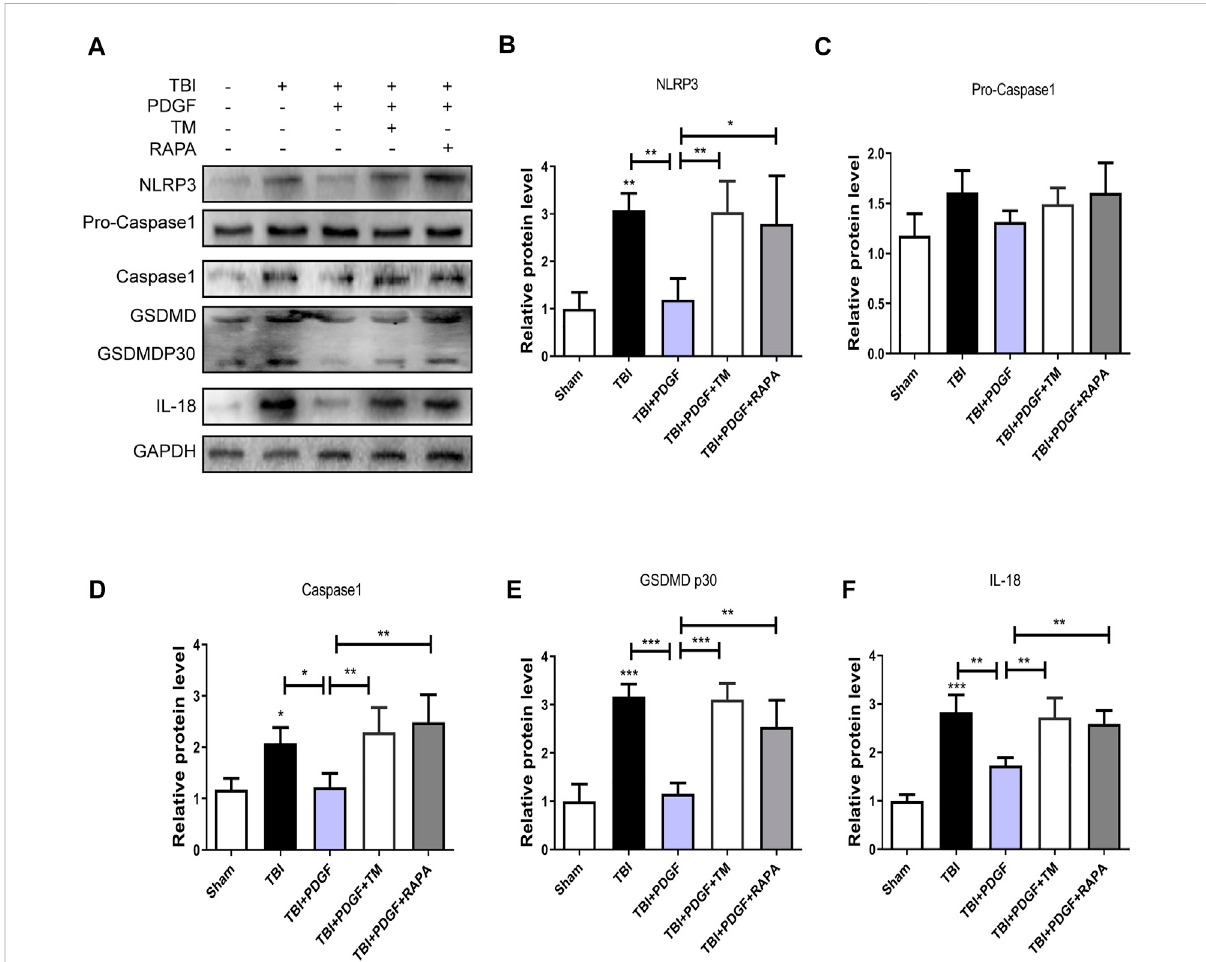
FIGURE 4 PDGF treatment inhibits the pyroptosis by blocking the ER stress and autophagy after TBI. (A) Representative western blot analyses of NLRP3, Pro-caspase1, Caspase1, GSDMD, GSDMDP30 and IL-18 in the cerebral cortex at 3 days after TBI. (B – F) Quanti fi cation of NLRP3, Pro-caspase1, Caspase1, GSDMDP30, and IL-18 in the ipsilateral brain cortex at 3 days after TBI. Data represent the mean ± SD, n = 3, * p < 0.05, ** p < 0.01 and *** p < 0.001 vs. the indicated